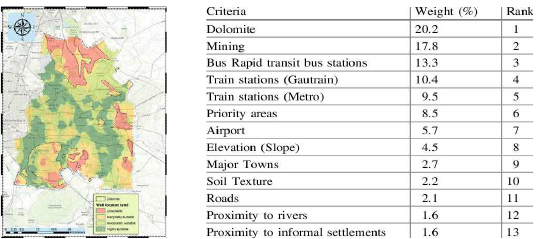
Figure 4: The Well Located Land Index Map and Criteria Weighting for Human settlements in City of